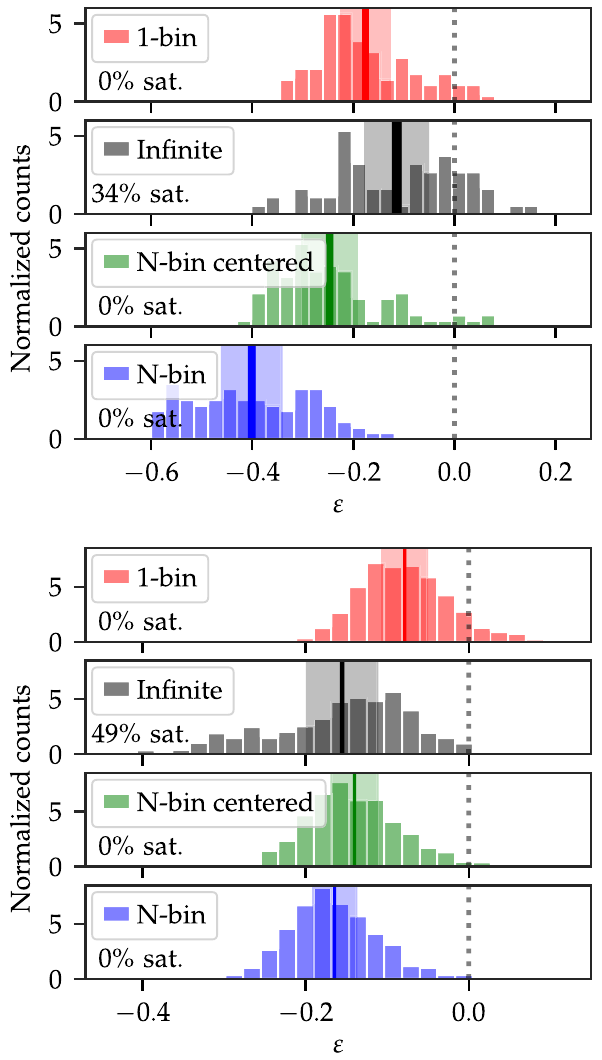
Fig. 14 Distributions of ε for each strategy, for a wide input signal (top)andadouble-bumpinputsignal(bottom).Thewidthofthecolored verticalline,centeredatthemean,correspondstothestandarddeviation of the mean, and the light shaded area is the standard deviation. A vertical black dashed line marks null bias. The percentage of saturated events for each strategy and input signal is indicated in each